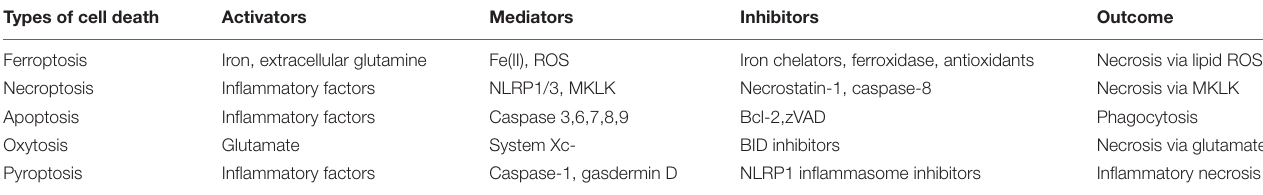
TABLE 1 | Comparison of different neuronal cell death